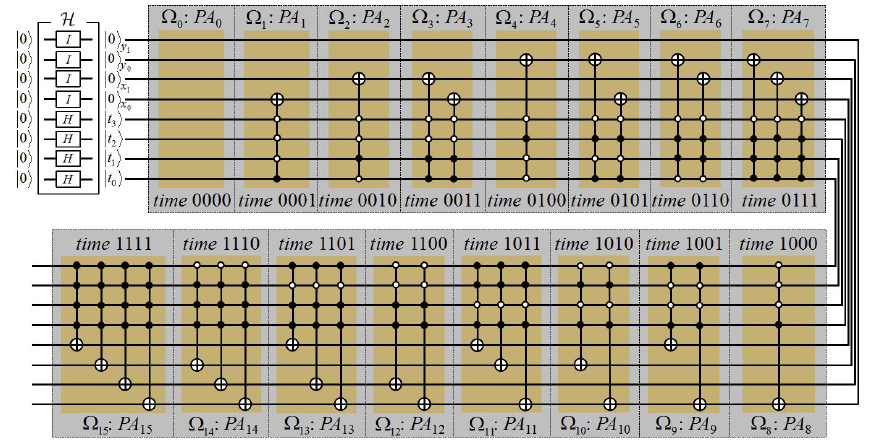
Figure 8. Circuit constructions for the example in Figure